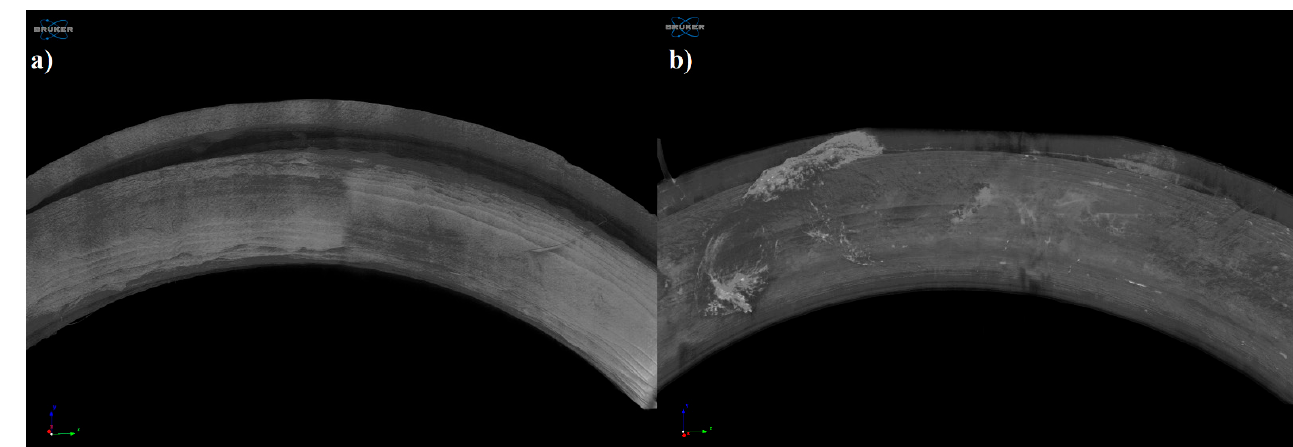
Figure 8. Reconstructed microCT image from the upper surface of the printed sample ( a ) and examined sample after the dissolution test ( b ). Image pixel size is 5 μ m.